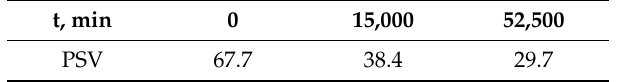
Table 3. Limestone polishing test data used to determine the k value [22]. PSV, polished stone value. t , min 0 15,000 52,500 PSV 67.7